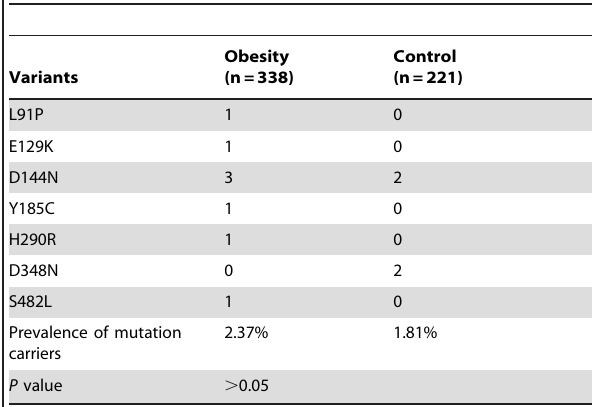
Table 2. Prevalence of rare non-synonymous mutations in FTO in obese and lean